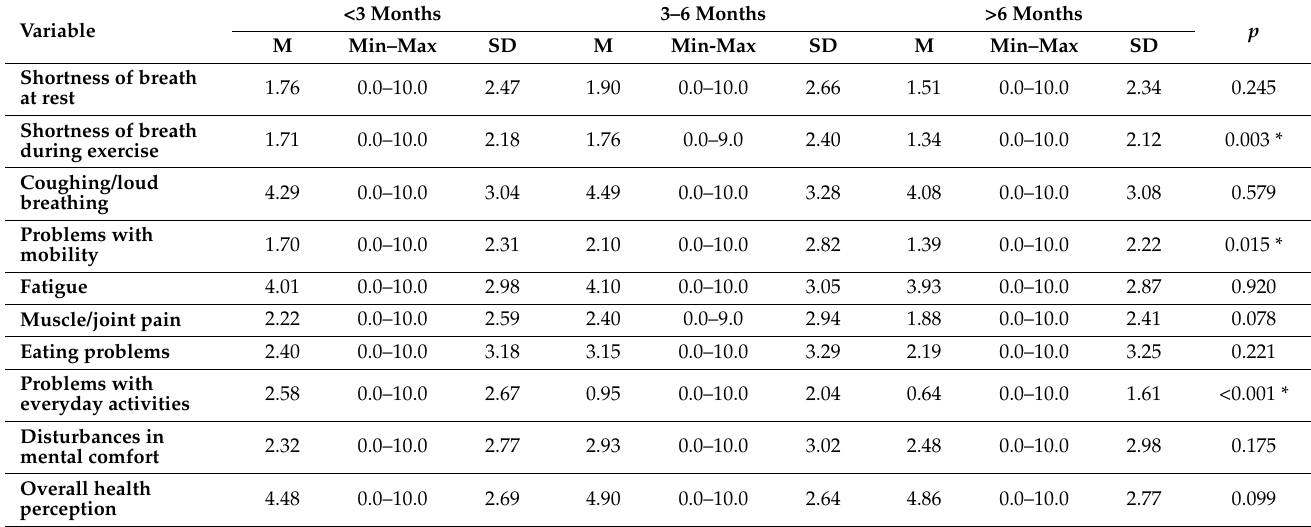
Table 4. Relationship between the time since the infection and complications after